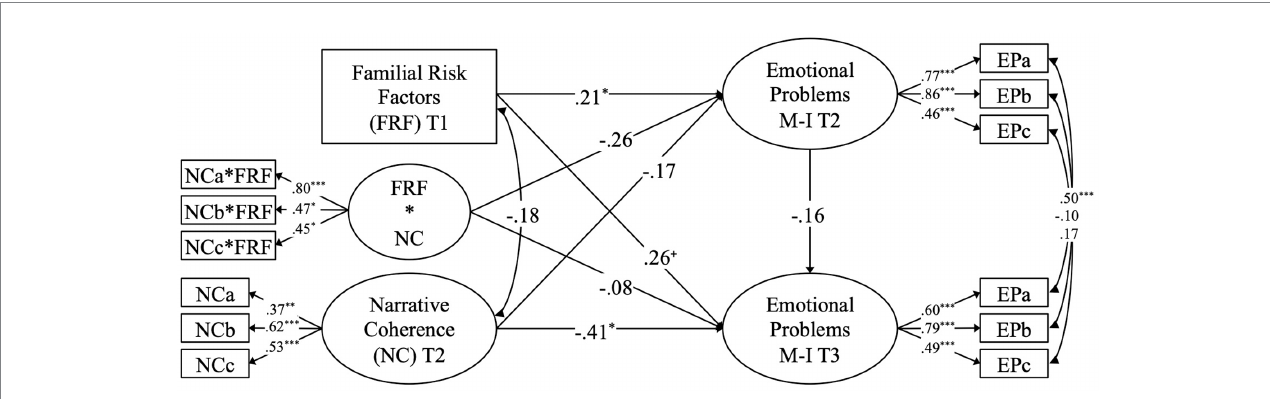
FIGURE 1 Standardized results from the model with narrative coherence (NC) as a moderator of the association between familial risk factors (FRF) and emotional problems (EP). FRF*NC represents interaction term between familial risk factors and narrative coherence. Control variables were omitted for simplicity. + p < 0.10; * p < 0.05; ** p < 0.01; *** p <